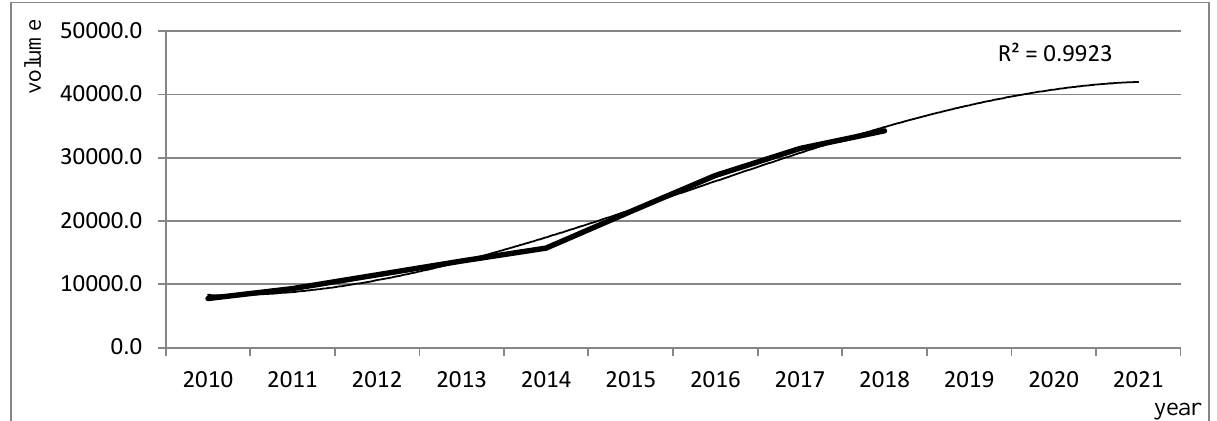
Fig. 2. Approximation of volumes of manufactured pharmaceutical products of Ukraine by polynomial trend line (n = 3) with forecasting till